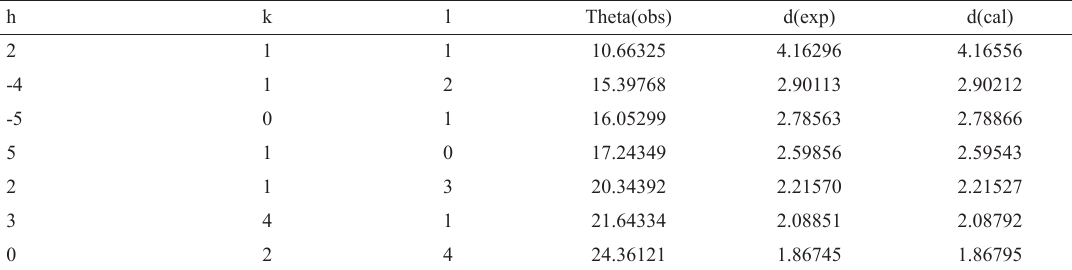
Table 1.1: Parameters evaluated from XRD of nanophotoadduct of potassium hexacyanoferrate(III) with diethylenetriamine.